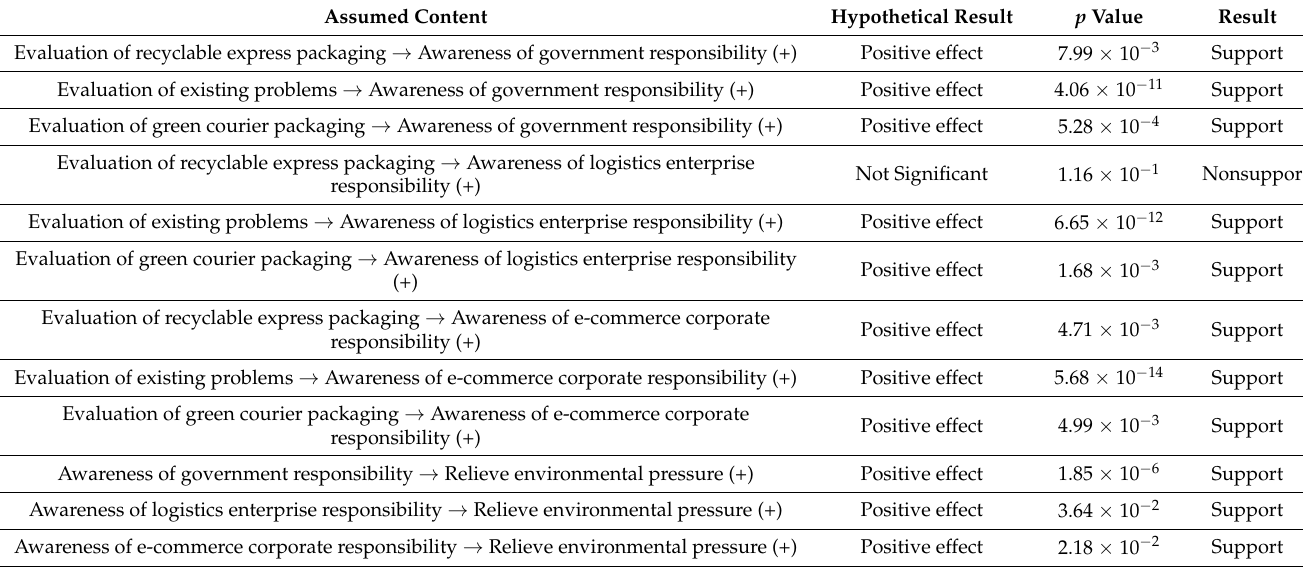
Table 14. Result of hypotheses testing.